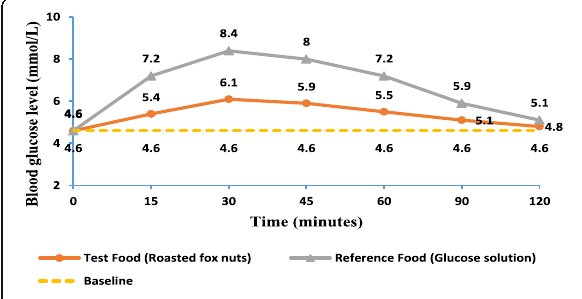
Fig. 5 Incremental area under the curve (iAUC) for test food (fox nuts) and reference food (glucose solution) ( n =